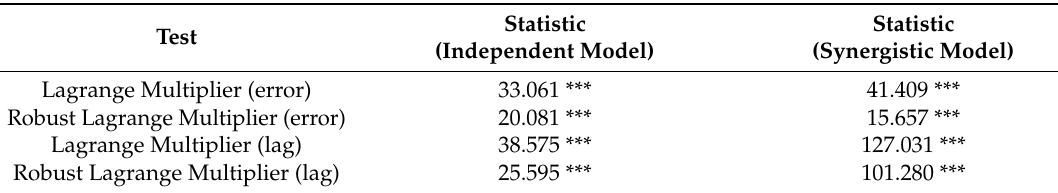
Table A4. The results of the Lagrange Multiplier (LM) test.